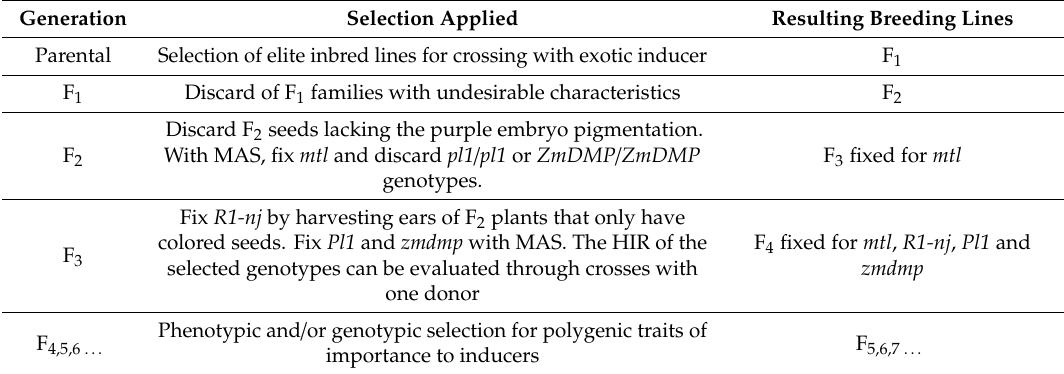
Table 4. Selection steps in haploid inducer